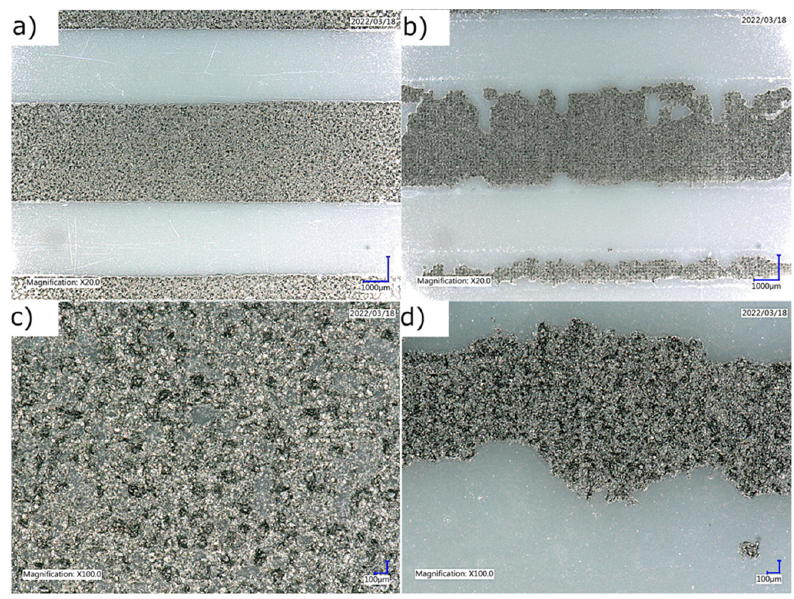
Figure 4. Comparison of microscopy images for two magnifications 20× and 100× of prints obtained for LARO paste ( a , c ) and hard TPU paste ( b , d ).